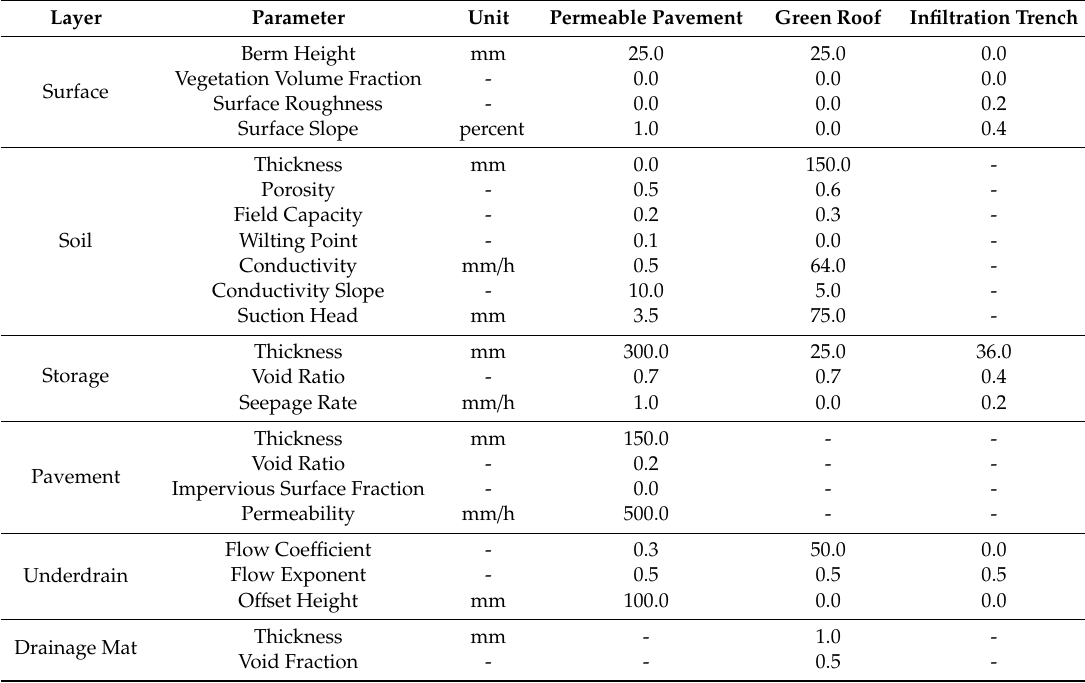
Table 2. Summary of LID Facilities and Associated Model Parameters